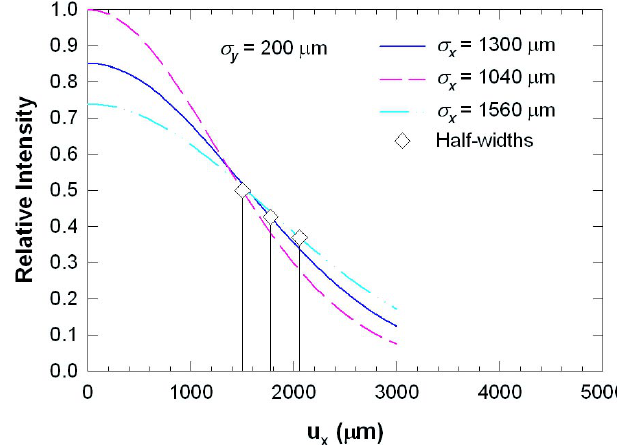
FIG. 9. A direct comparison of the OTR (closed circles) and ODR (open circles) Gaussian-fit horizontal profile sizes during the quadrupole field scan. The vertically polarized ODR tracks the beam-size